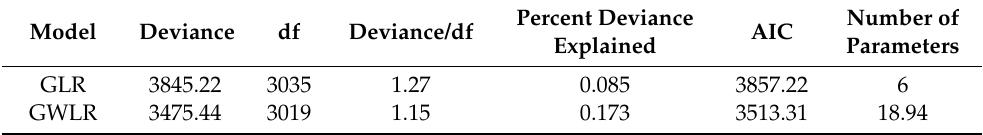
Table 8. Comparison of model goodness-of-fit statistics.